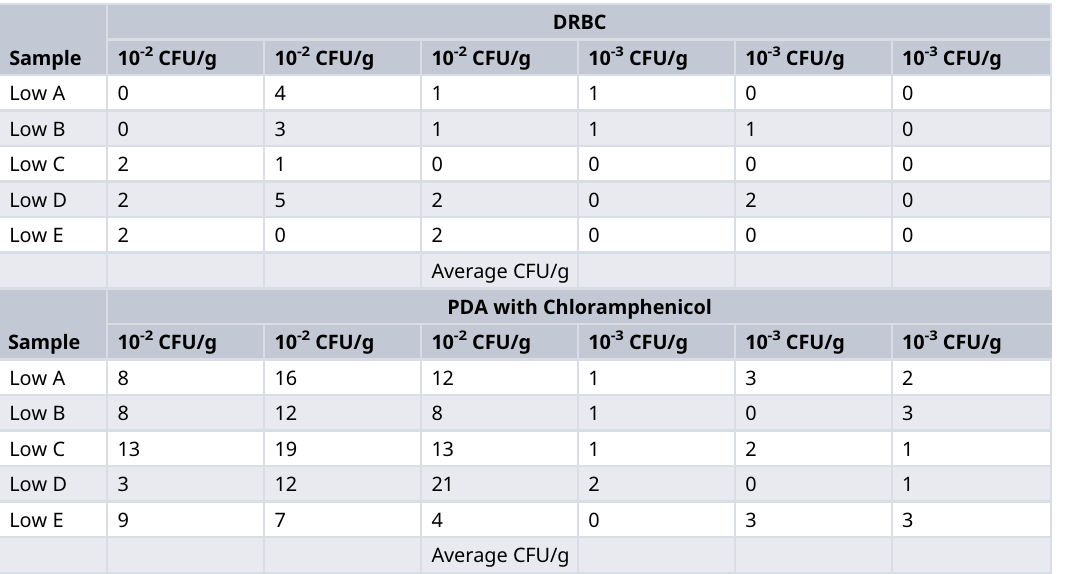
Table 2. Cannabis samples plated on 3 different media. Plating on different media demonstrates a LOG scale difference in Colony Forming Units (CFU) with each plating medium. Sequencing can attribute only half of the colonies as bacteria on Potato Dextrose Agar (PDA) with chloramphenicol. This implies a 5-fold under counting of yeast and mold on Dichloran Rose Bengal